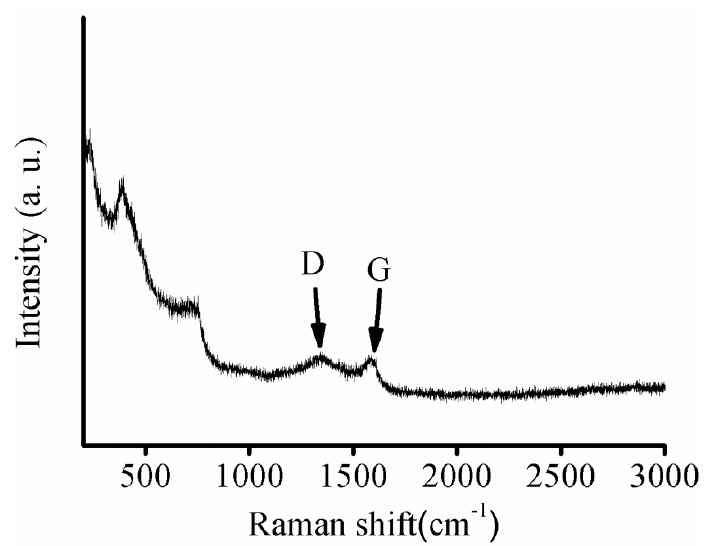
Figure 4. Raman spectrum of the (Bi 0.48 Sb 1.52 )Te 3 thick film annealed at 550 °C for 1 h in 10 − 2 Pa vac- uum.